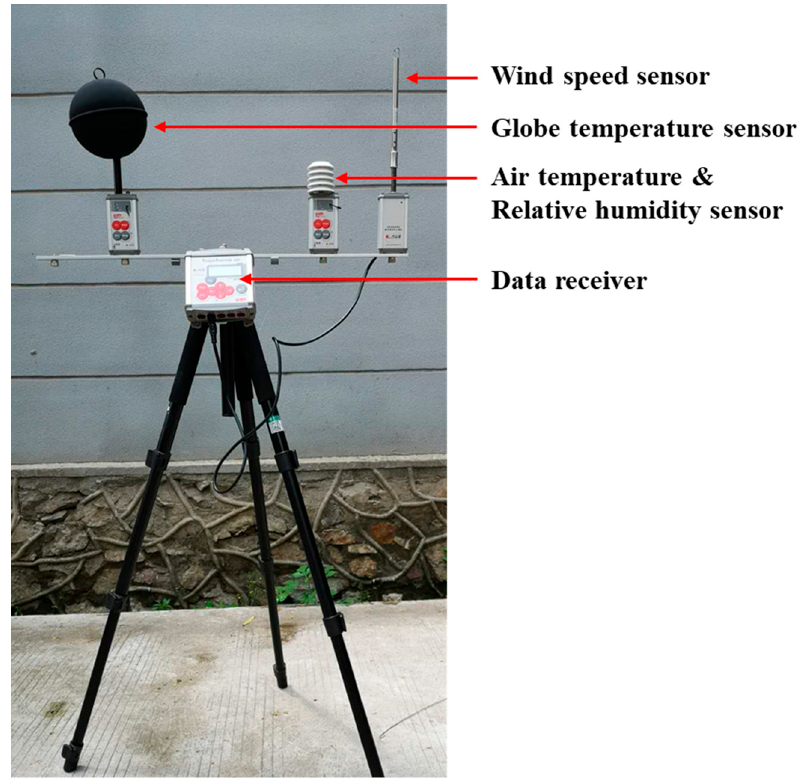
Figure 3. Mobile meteorological station used in the study. Table 2. Sensor specification for the portable weather station used in the study.